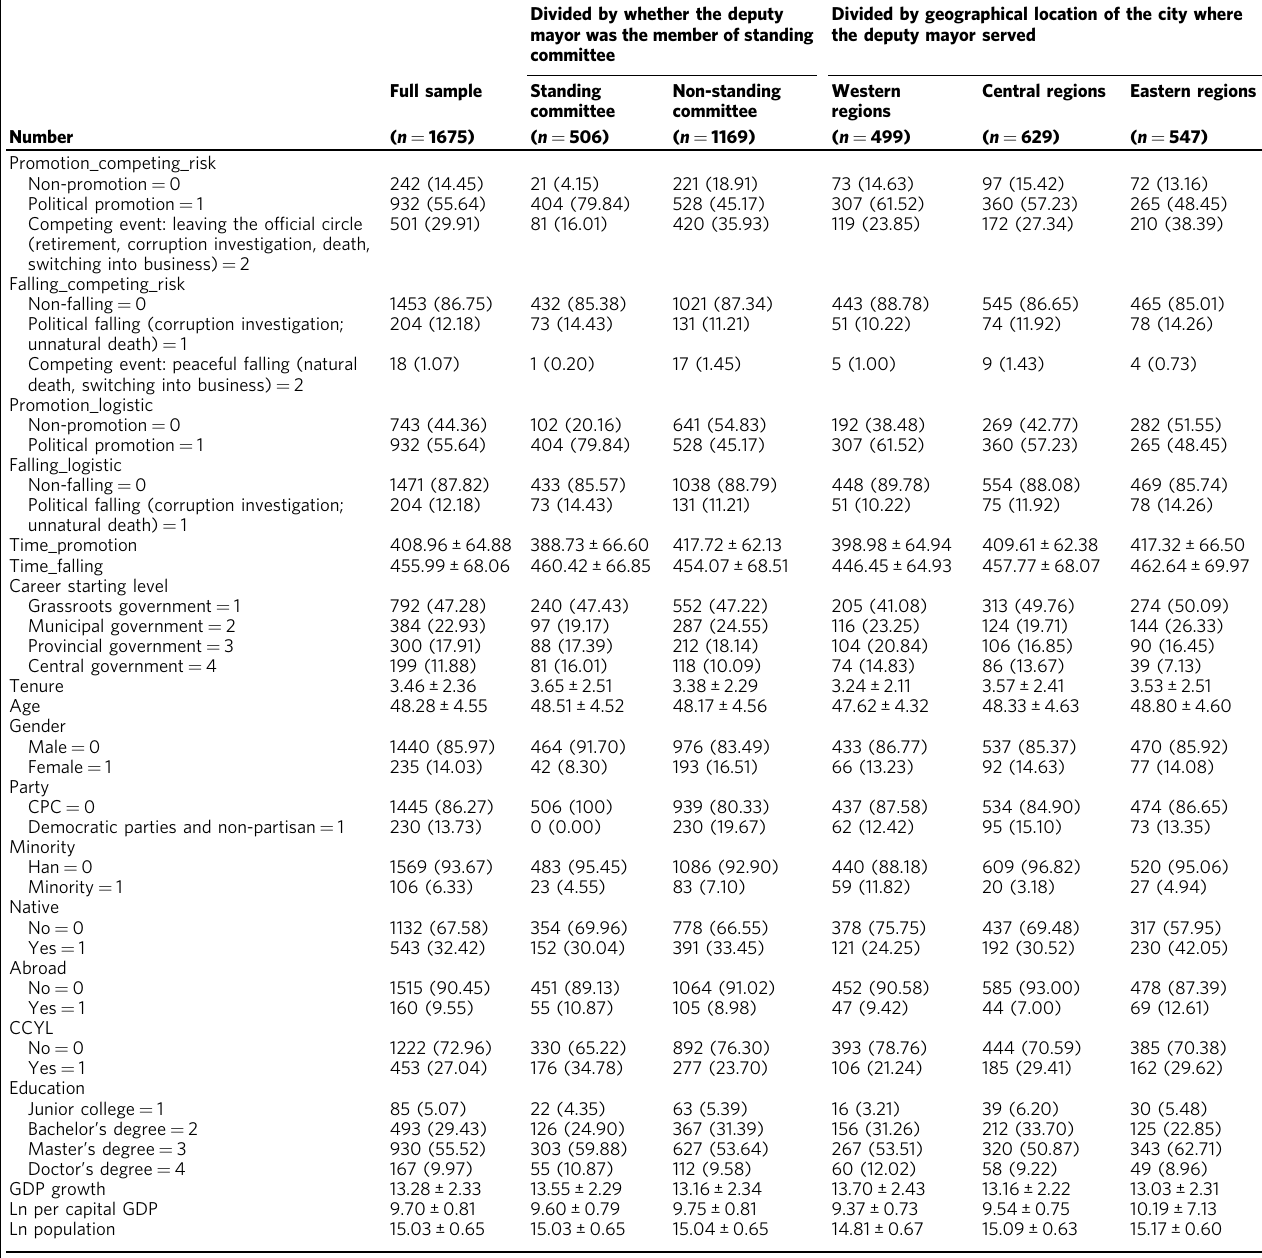
Data are expressed as number (percentage) for categorical variables and mean±standard deviation for continuous